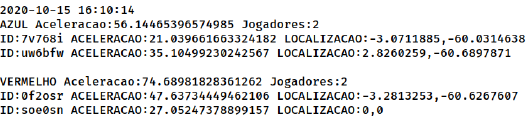
Figure 4. Example of log generated by the Bumbometer application.